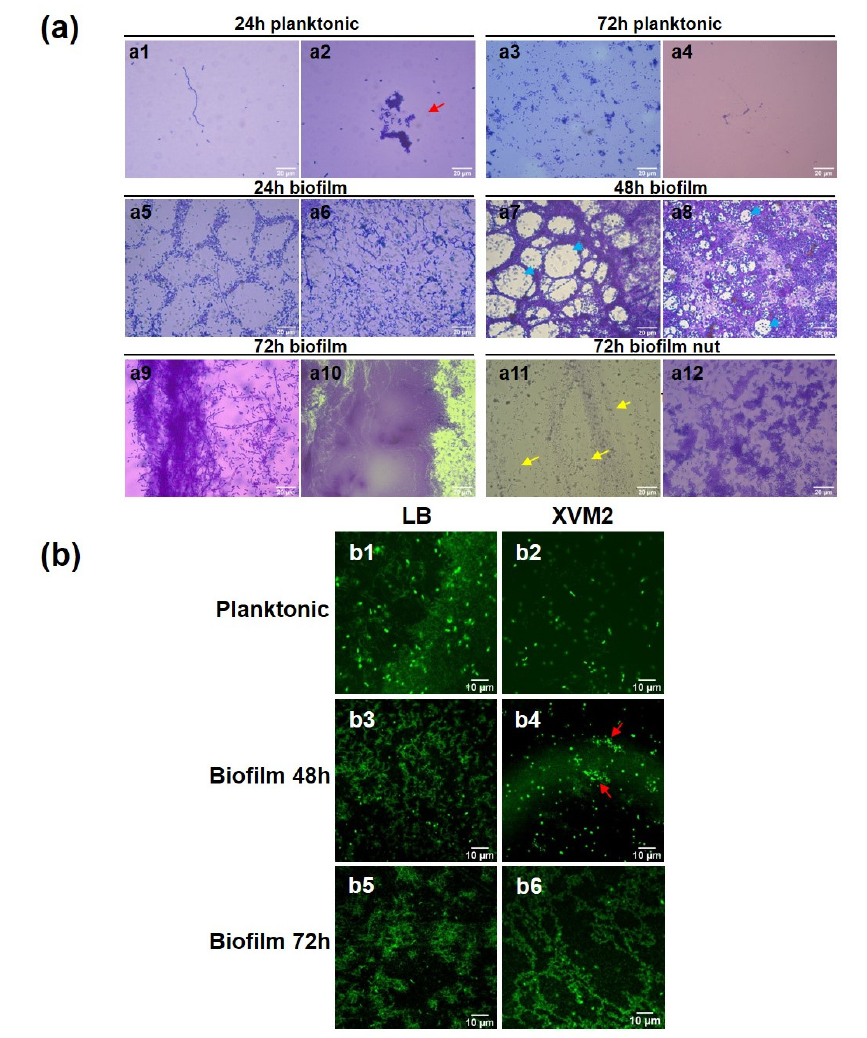
Figure 3. ( a ) Optical microscopy of morphological features of CITA 33 strain in LB medium. Samples were stained with crystal violet at different stage: 24 h of bacteria growth in shaking conditions (1,2), 72 h of bacteria growth in shaking conditions (3,4), 24 h of biofilm maturation in dried conditions (5,6), 48 h of biofilm maturation in dry condition (7,8), 72 h of biofilm maturation in dry conditions (9,10), 72 h of biofilm maturation without medium elimination (11,12). ( b ) CLSM imaging of planktonic cells in LB (1) and XVM2 (2), 48 h mature biofilm in LB (3) and XVM2 (4) and 72 h mature biofilm in LB (5) and XVM2 (6).